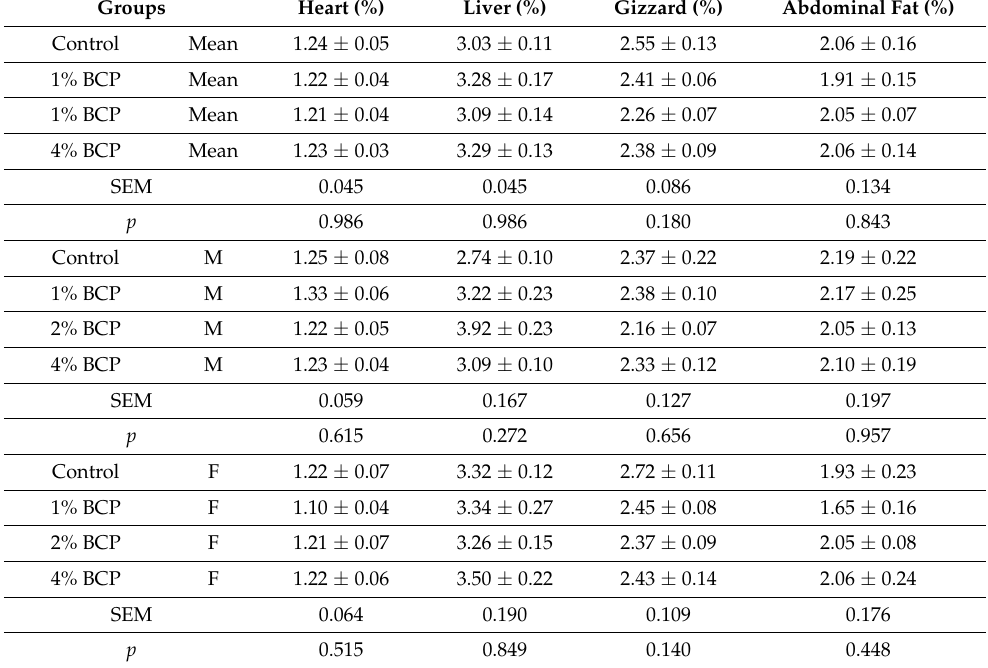
Table 5. The effect of the different levels of BCP supplementation on giblet proportion and abdominal fat